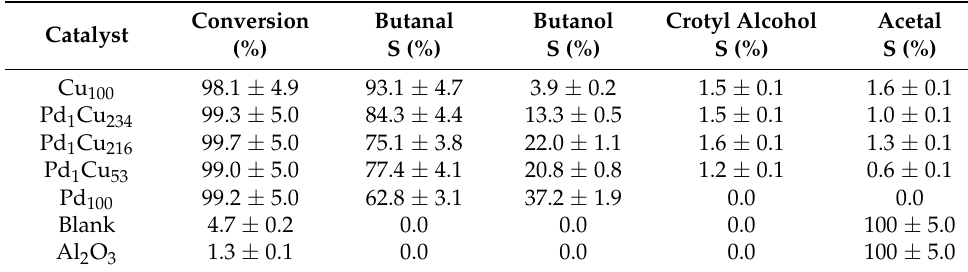
Table 2. Summary of the catalytic conversion and selectivity (S) for the hydrogenation of croton- aldehyde using Pd/Cu catalysts. Reaction conditions: 7 h, 50 ◦ C, 1.5 bar H 2 , 600 RPM, and 10 mg of catalyst. Conversion Butanal Butanol Crotyl Alcohol Acetal Catalyst (%) S (%) S (%) S (%) S (%) Cu